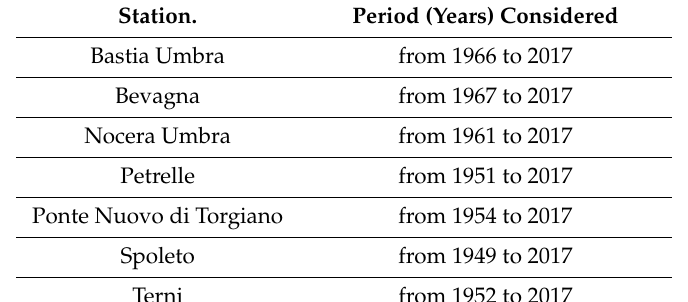
Table 1. Stations selected for the work and the period of data considered. Station.